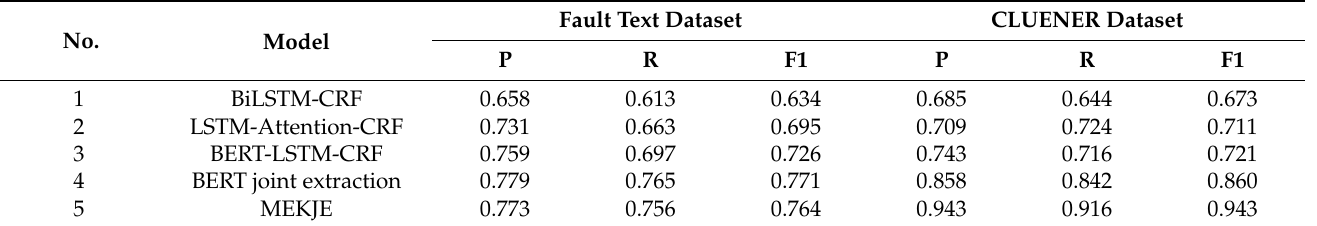
Table 5. Fault Entity Label